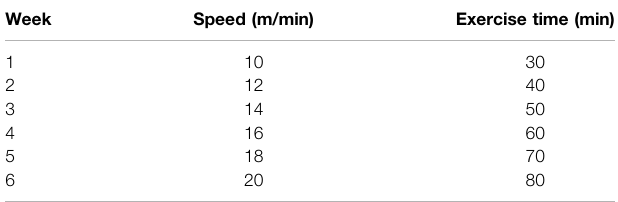
TABLE 1 | Hypoxic training duration and intensity